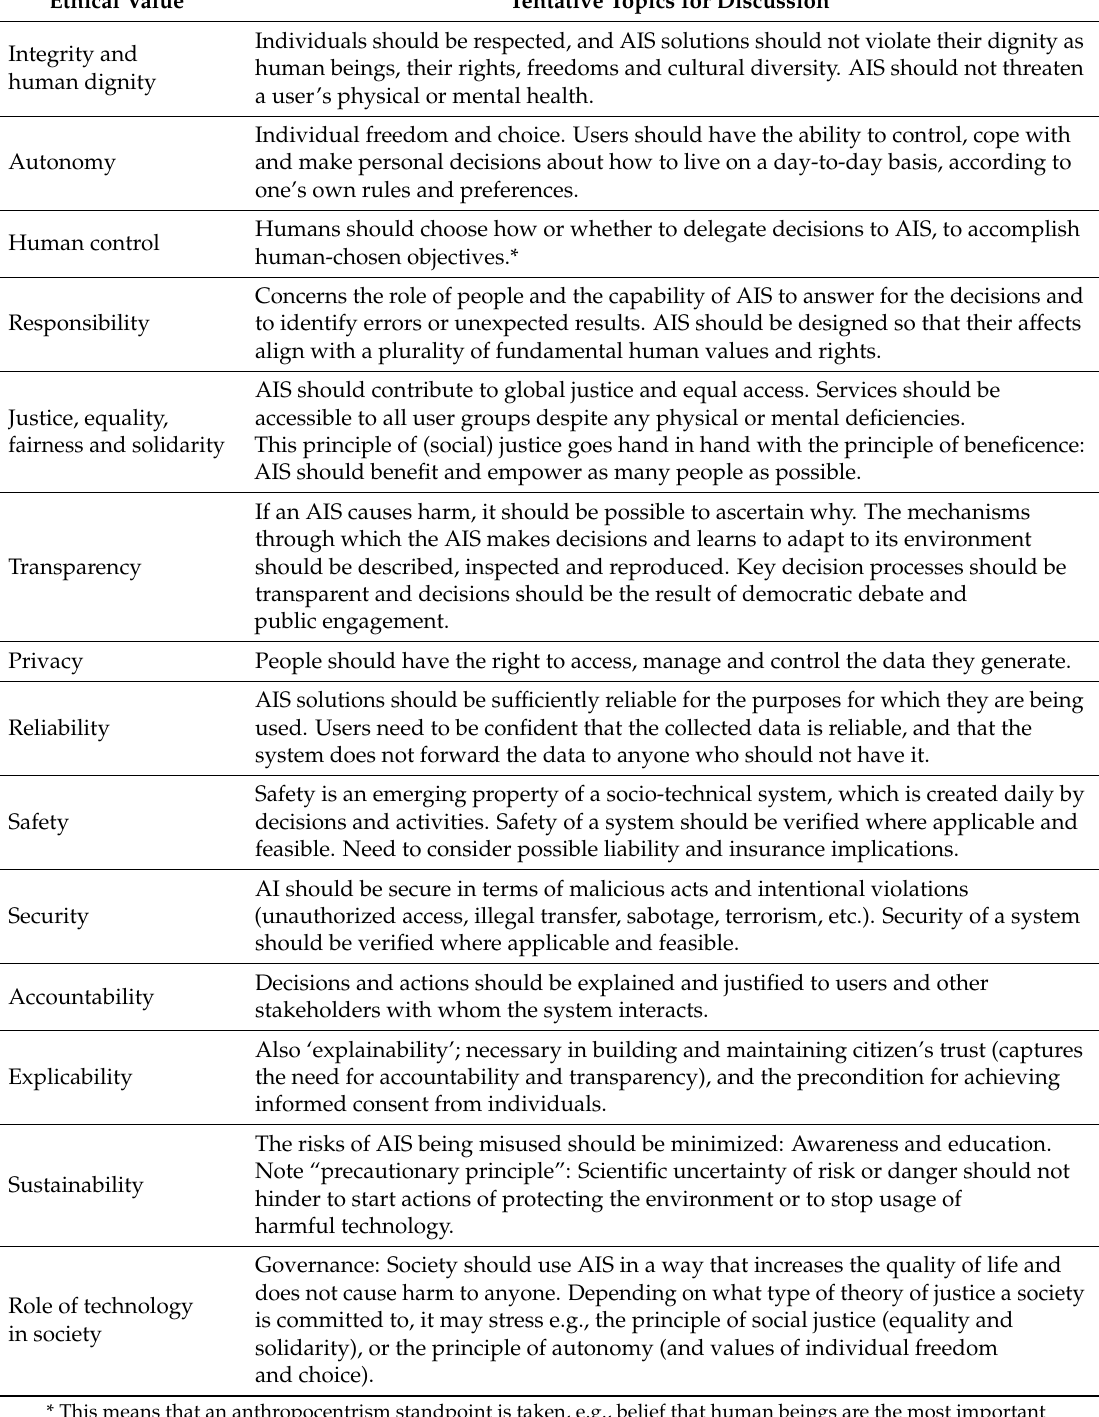
Table 2. A preliminary set of ethical values modified for the context of AIS. Tentative Topics for